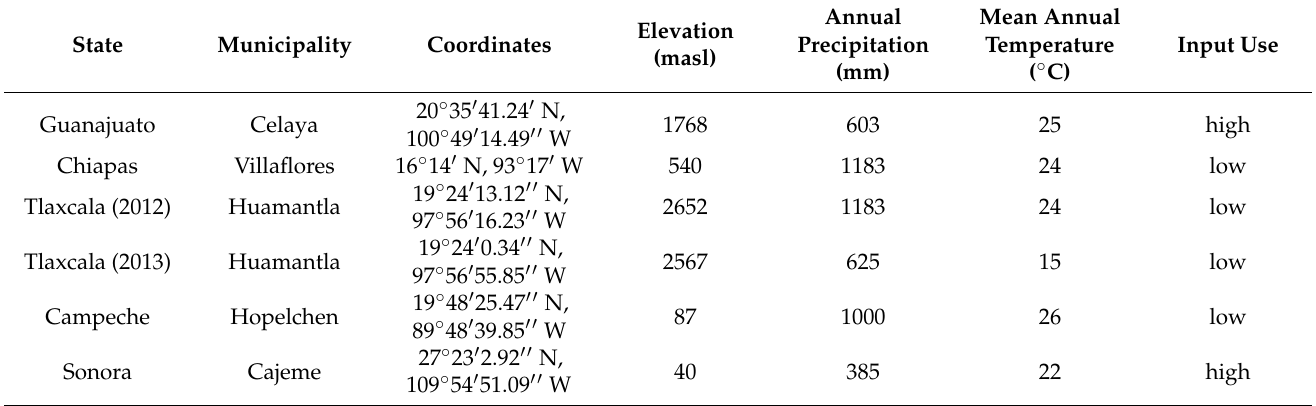
Table 1. State, municipality, coordinates, elevation, annual precipitation, mean annual temperature, and input use level of experimental sites in Mexico, from 2012–2013, and from 2016–2019.